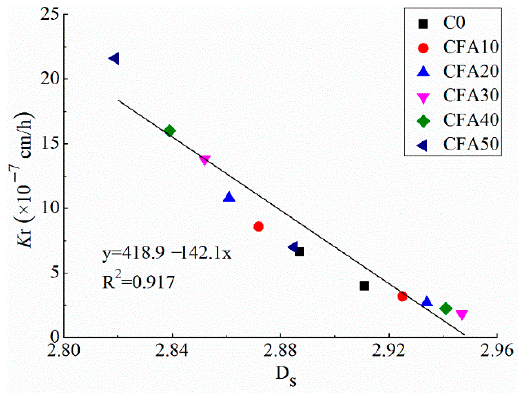
Figure 5. The relationship between K r and D s